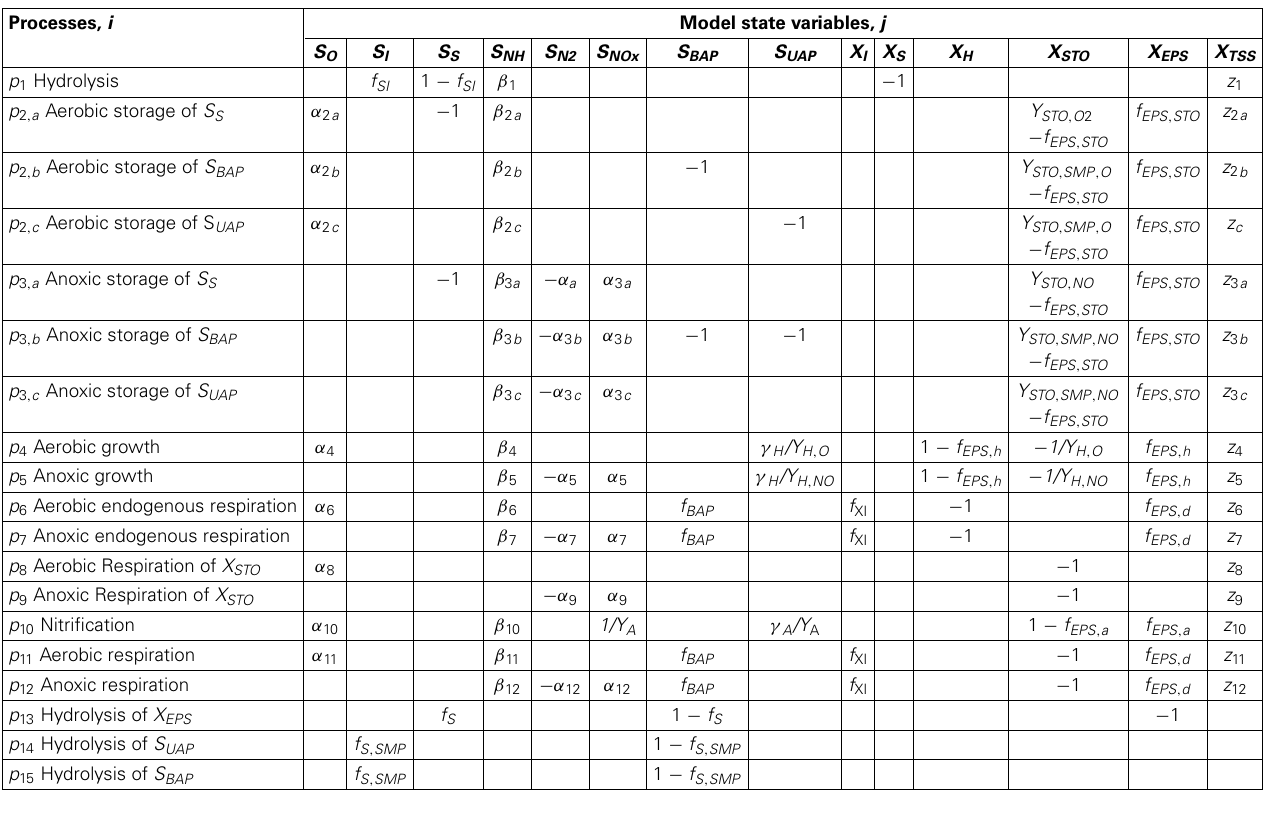
Table 3 | Stoichiometric matrix includes all the stoichiometric coefficients ( ν ij ). Processes,